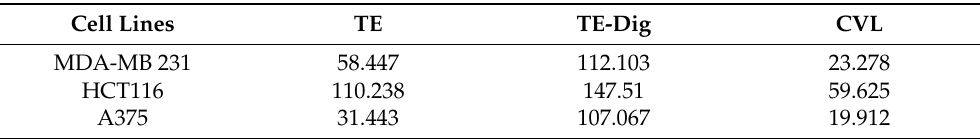
Table 4. IC50 values (50% cell viability inhibitory concentration) determined for T. spicata ethanolic extracts (TE and TE dig) and Carvacrol (CVL) in the three cell lines over a long-term (24 h) period under